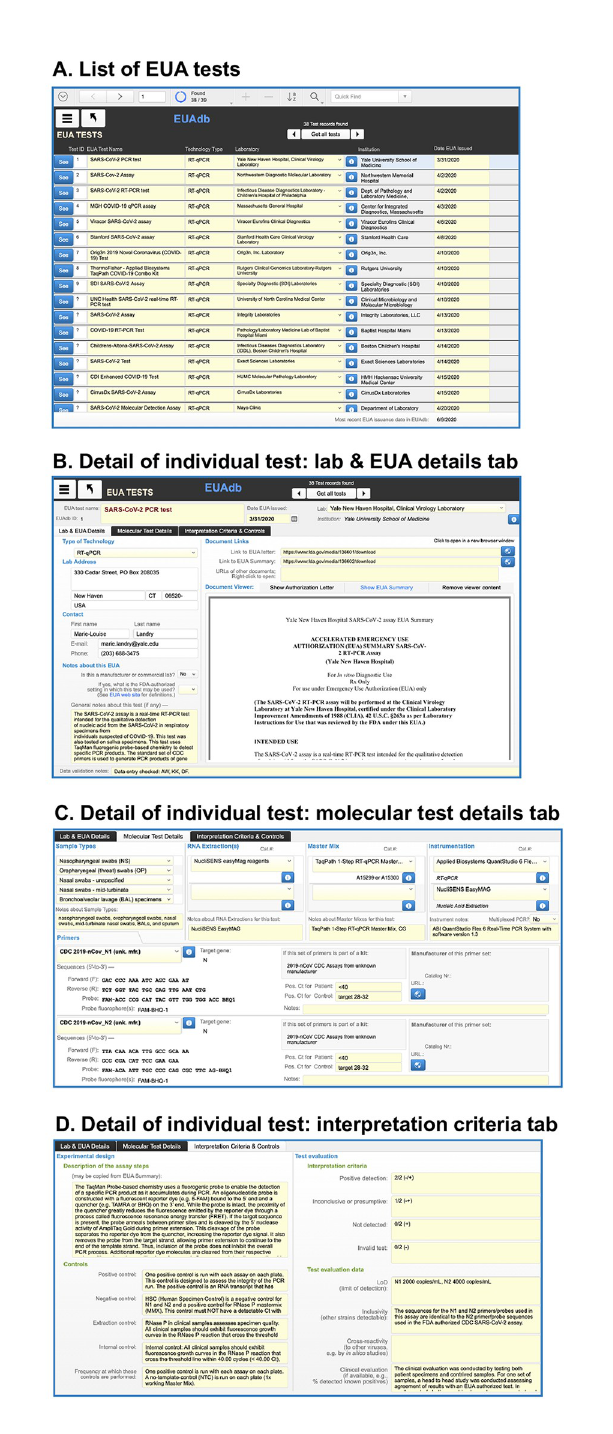
Fig 4. Example showing details for a particular test chosen from a found list of tests. See text for explanation.